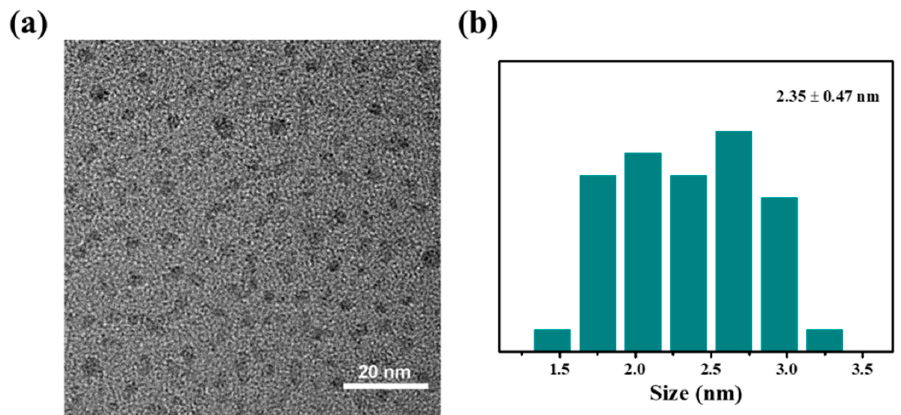
Figure 1. ( a ) TEM image and ( b ) particle size distribution histogram of FNCDs.